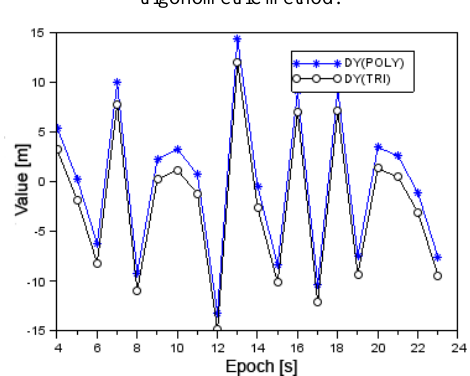
Figure 3. The values of DY parameter based on polynomial and trigonometric method.